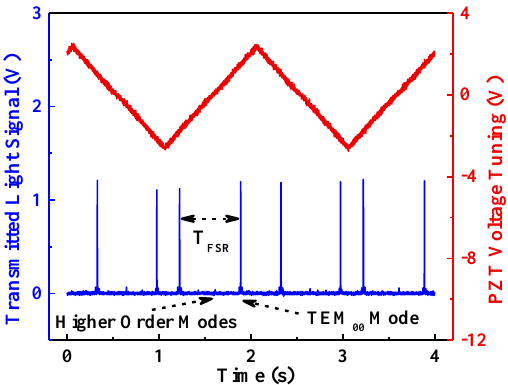
Figure 4. The cavity transmission spectrum. The red line shows the PZT driver voltage signal; the blue line shows the transmitted light signal changes following the applied PZT driver signal.